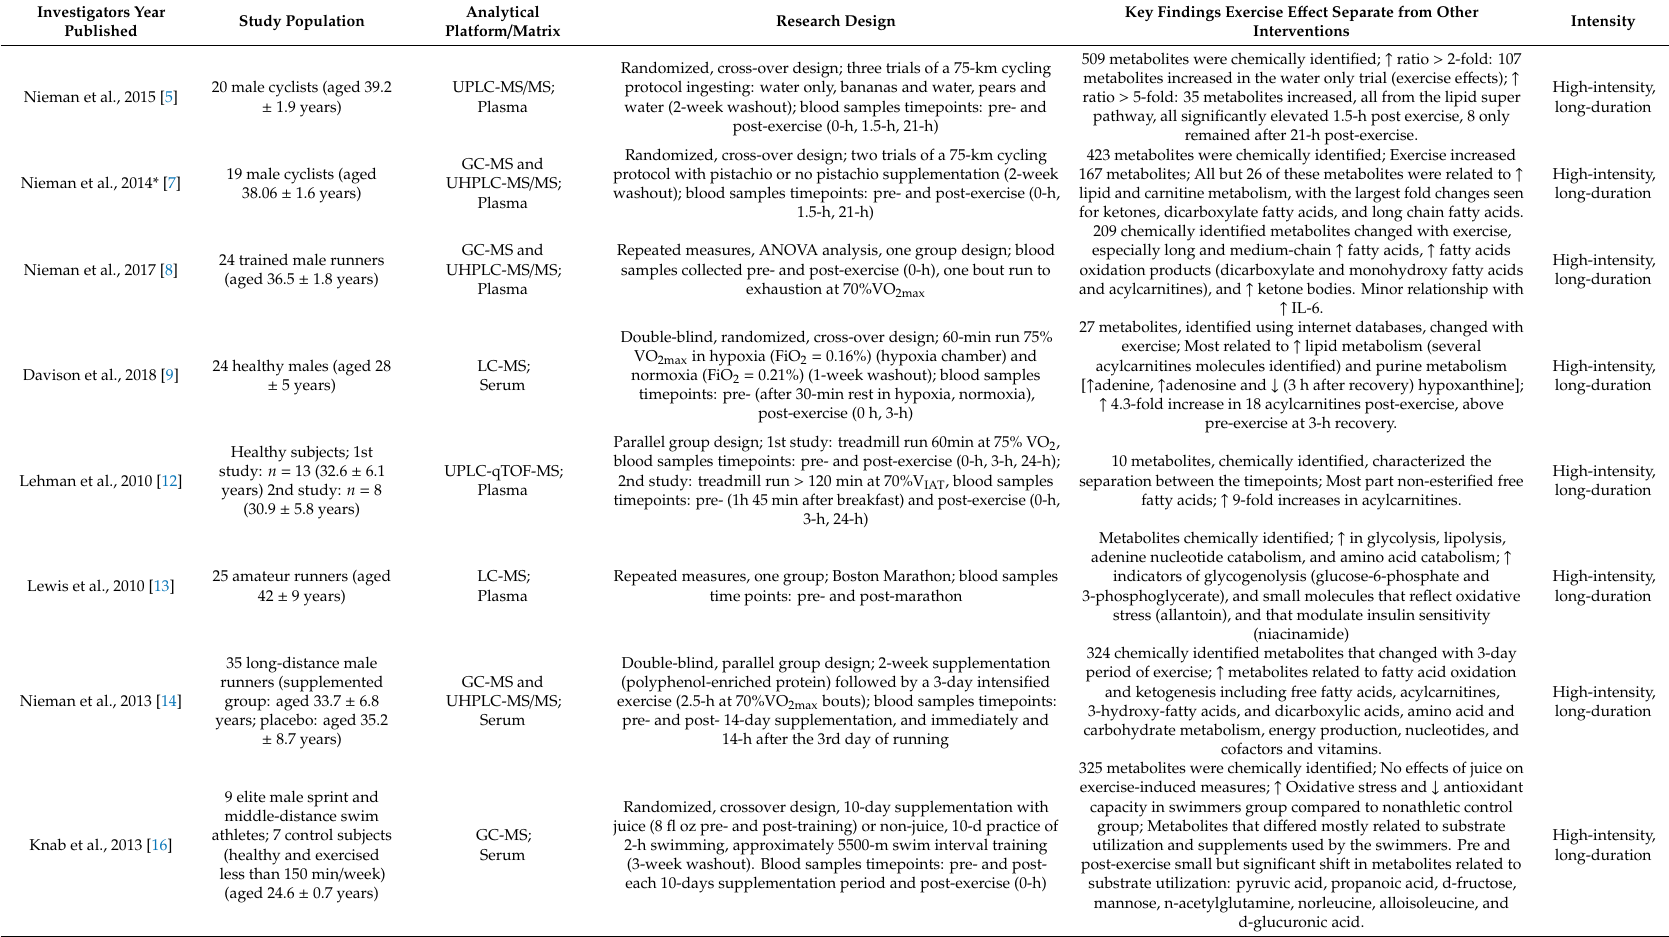
Table 2. High-intensity and long-duration